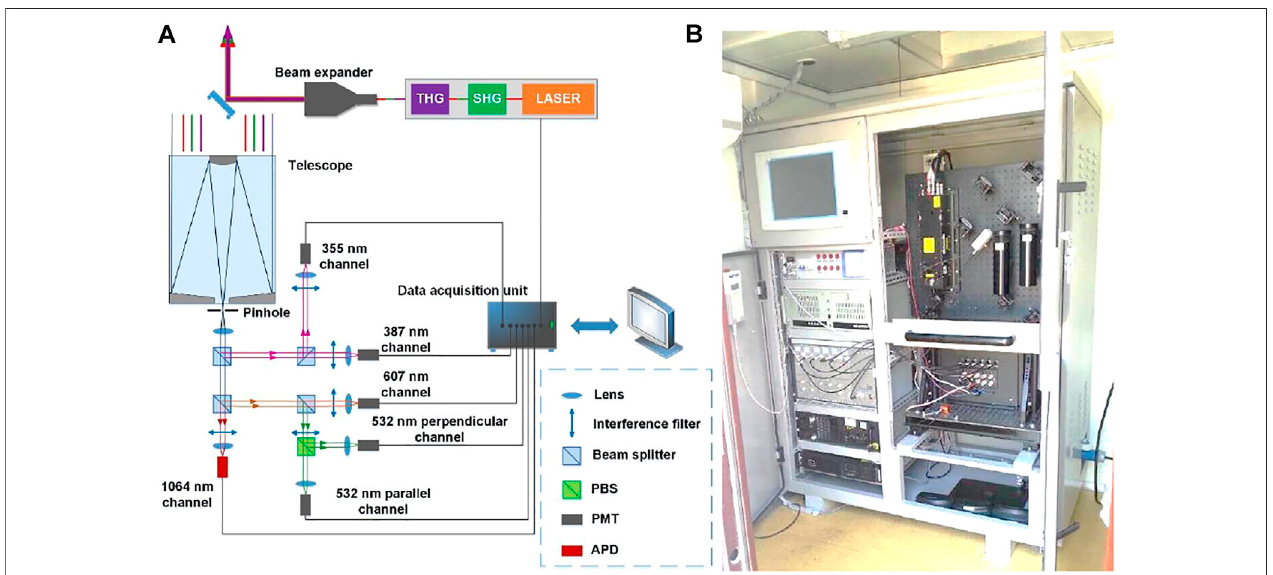
FIGURE 1 | (A) MWAL ’ s structure. (B) MWAL ’ s cabinet appearance.